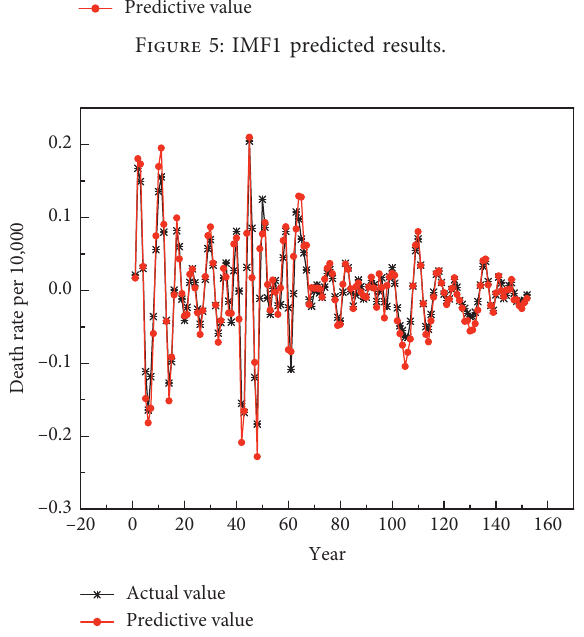
Figure 7: IMF3 predicted results.